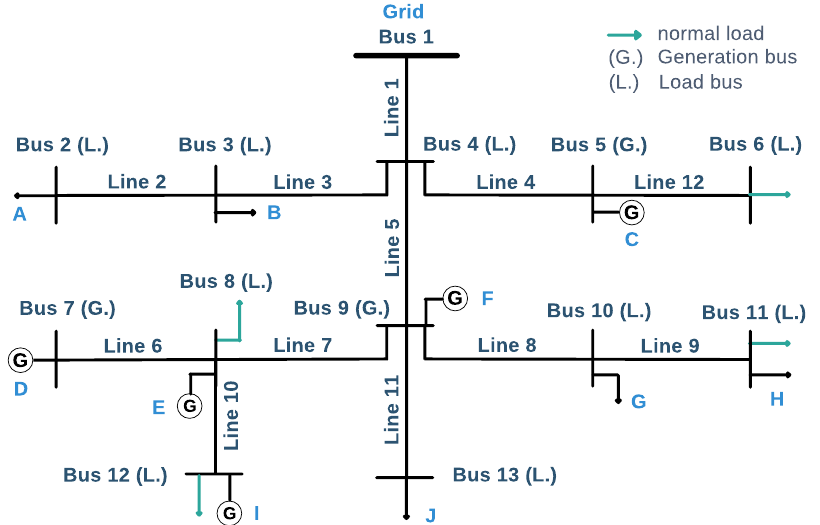
Figure 6. The line length represents the distance between nodes.